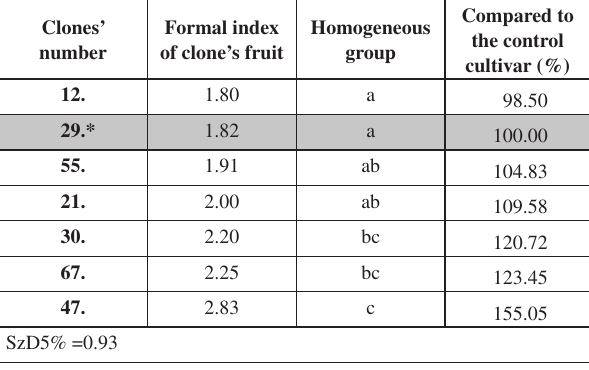
Table 7. The formal index of Lycium clone’s fruit, 2011.